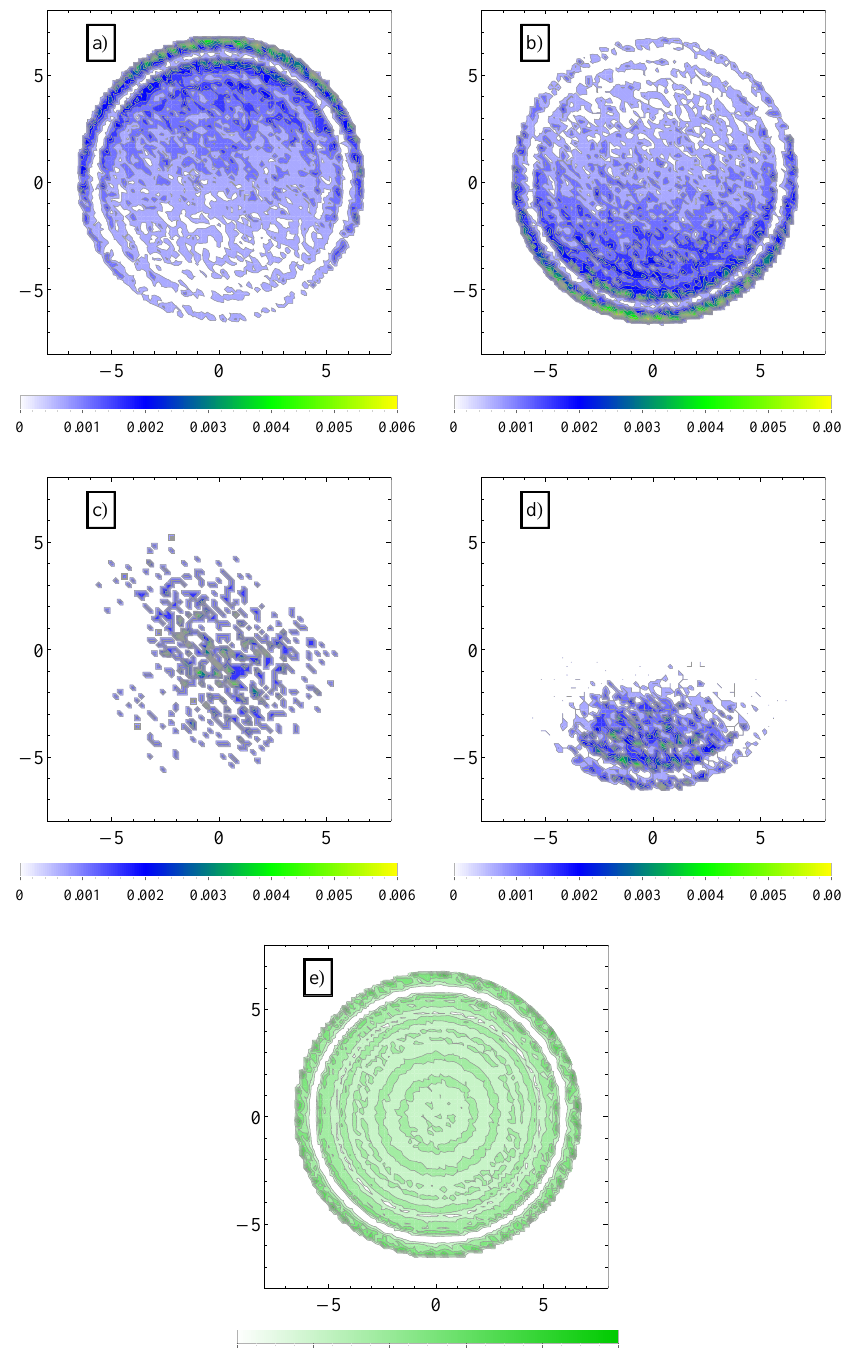
Figure 6. ( a ) Contour plot of average number density distribution of counterions and ( b ) coions of added salt in a cross-section perpendicular to the axis of the cylinder geometry, T 12